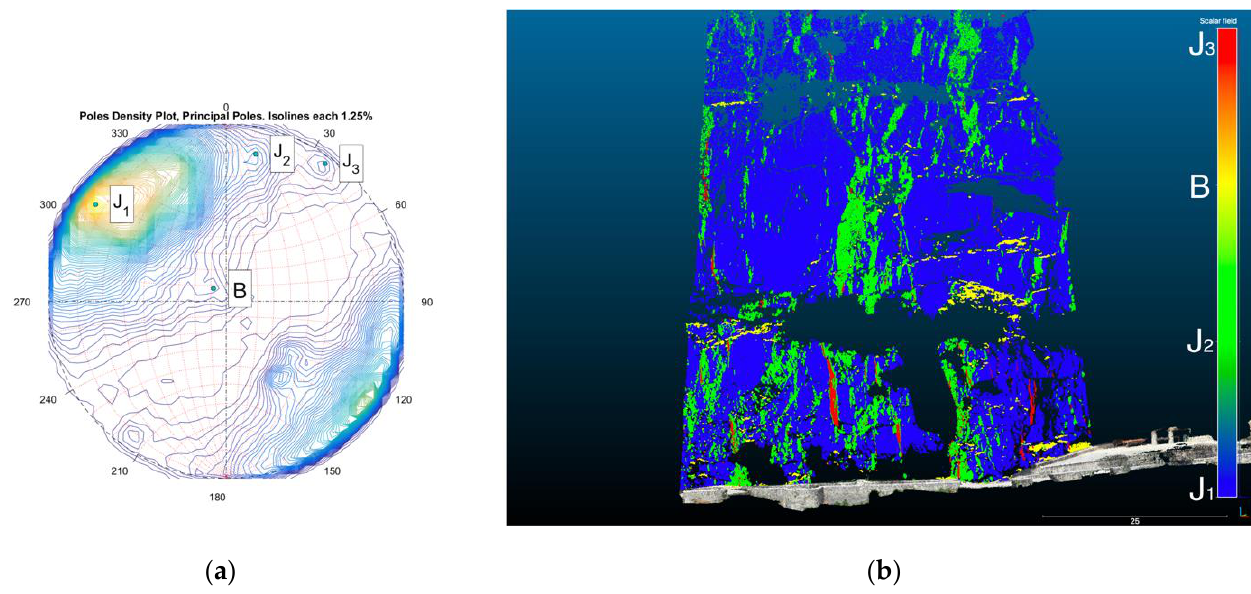
Figure 8. ( a ) Stereographic projections of the DSE-derived discontinuity sets for U3 and ( b ) the visual interpretation of the four (4) main sets in the 3D point cloud.